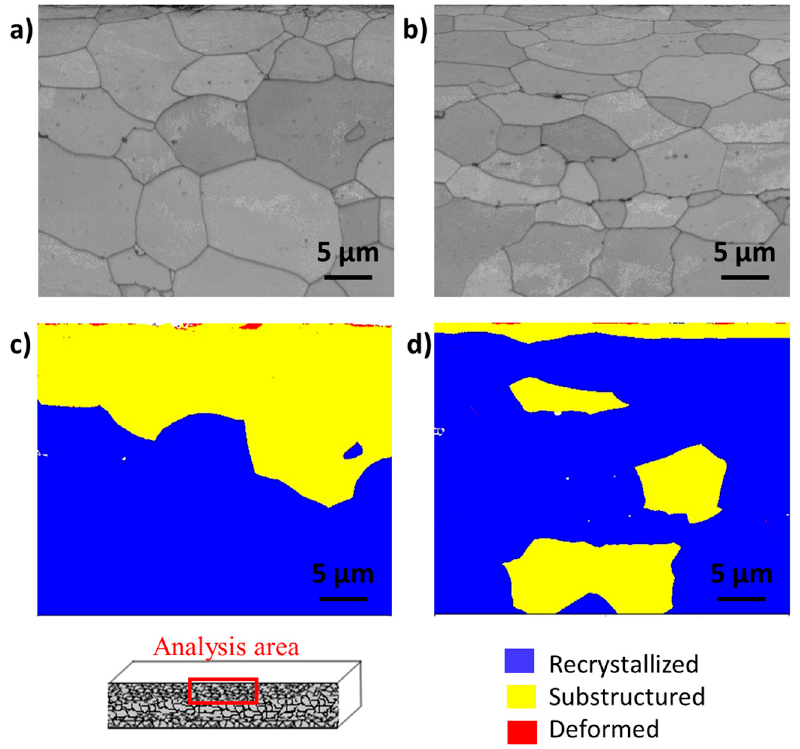
Figure 4. ( a ) BC map acquired on the FSS1 sample, ( b ) BC map acquired on the FSS2 sample, ( c ) DefRex map acquired on the FSS1 sample, ( d ) DefRex map acquired on the FSS2 sample. All the data were acquired at the surface of the sheets prepared in cross-section geometry.